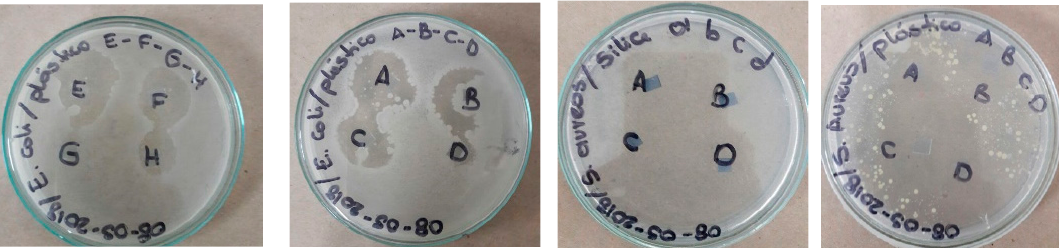
Figure 7. Antibacterial activity in colonies of Escherichia coli and Staphylococcus aureus . Table 3. Measurements of the inhibition ring according to the Institute of Clinical and Laboratory Standards (CLSI, 2015).